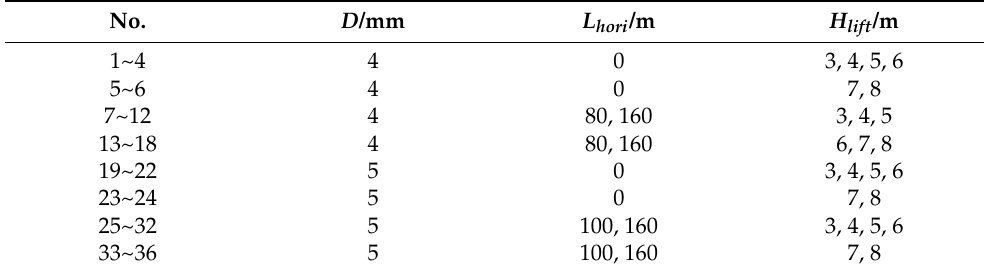
Table 1. Experimental schemes of siphon drainage (T = 25 ◦ C, P la = 100.53 kPa).